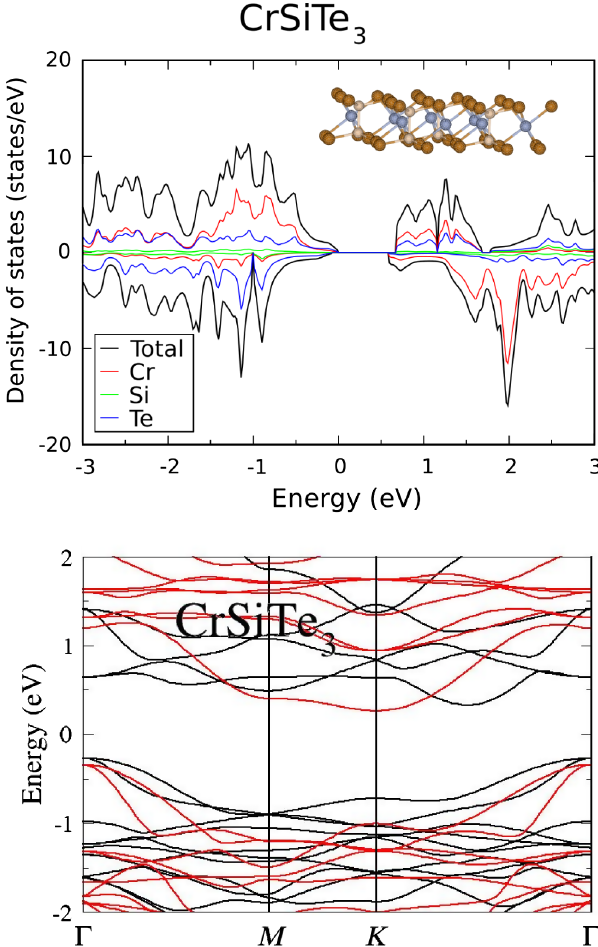
FIG. 3. Density of states (upper panel) and band structure along the high-symmetry directions (cid:3) - M - K - (cid:3) (lower panel) of . Note that the density of states is also ferromagnetic CrSiTe 3 shown as an atomic projected property. The Fermi level is at zero energy. In the inset of the upper panel, the two-dimensional crystal structure is also